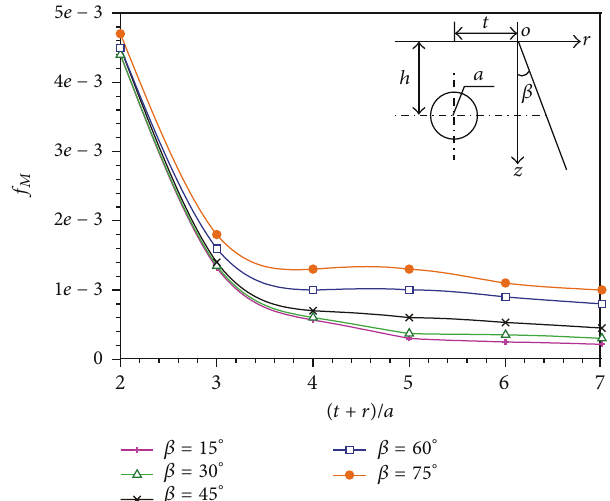
Figure 7: The Mises stress varies with the distance (𝑡 + 𝑟)/𝑎